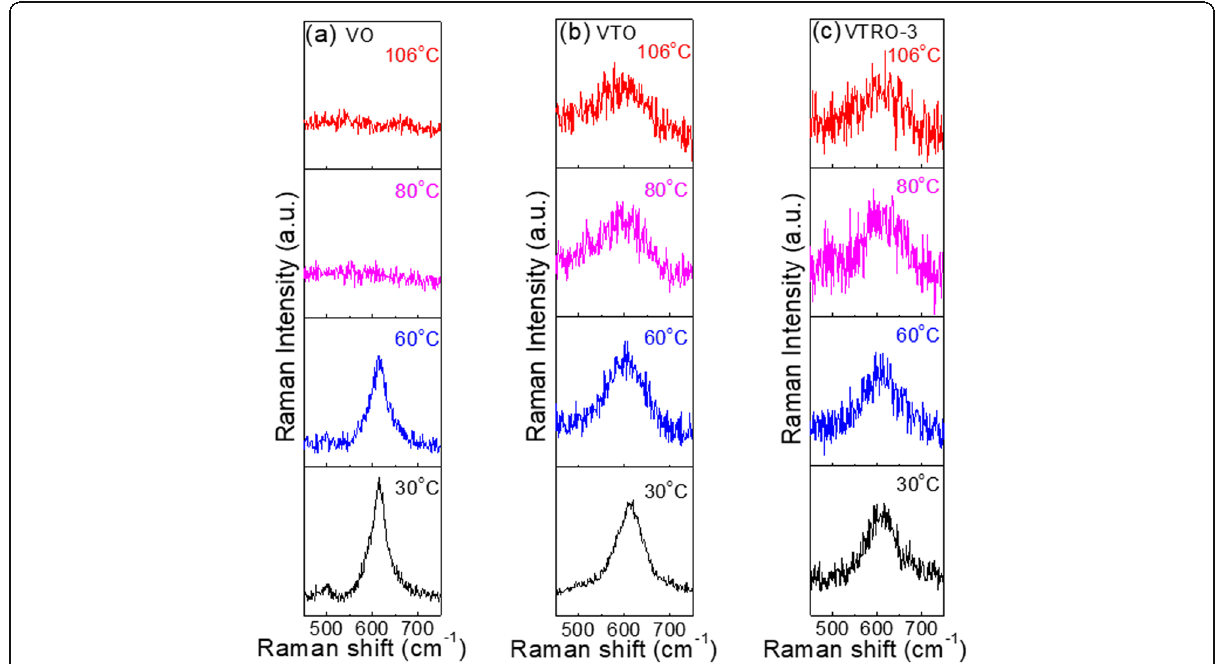
Fig. 7 Temperature-dependent Raman scattering characteristics of a VO, b VTO, and c VTRO-3 during the